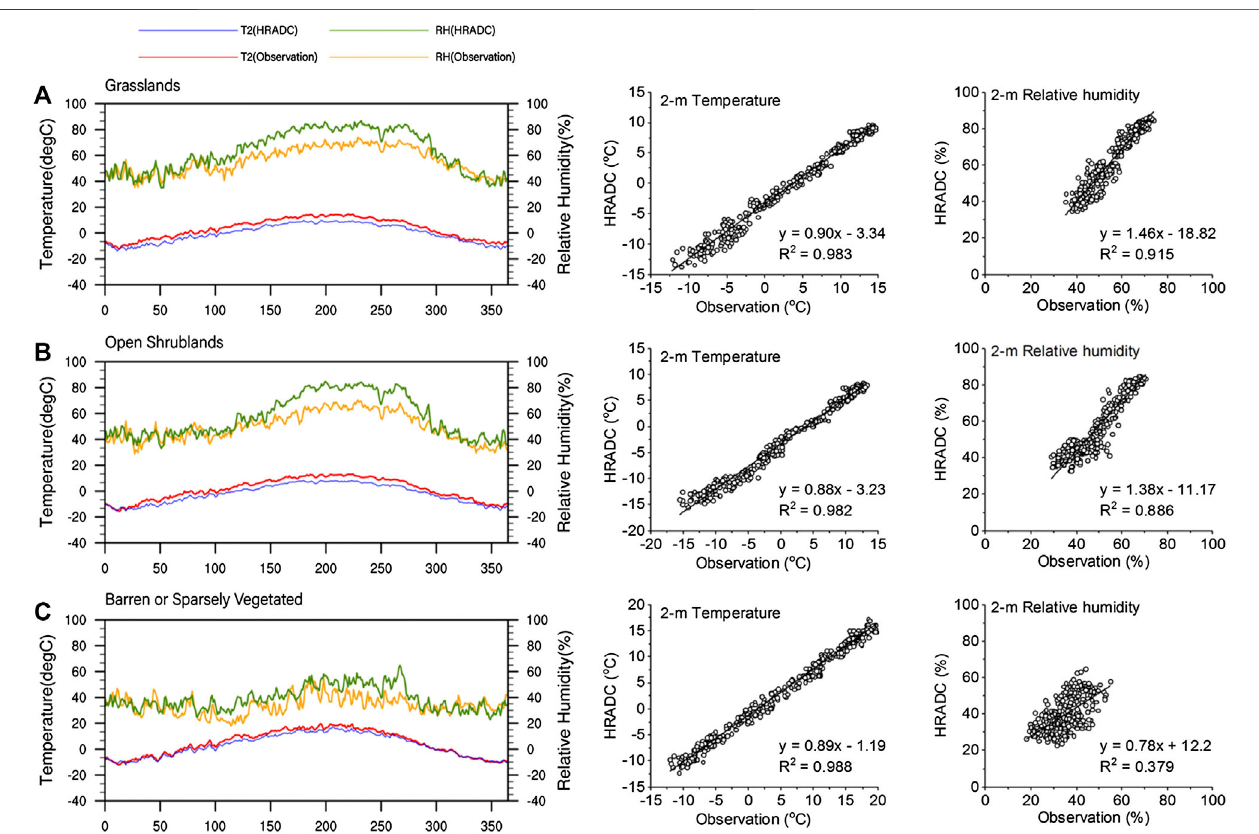
FIGURE 3 | Comparison of observations and High-Resolution Assimilation Dataset of the Water-Energy Cycle in China simulations, from three different underlying surfaces in Qinghai-Tibet Plateau, of the average daily value of 2-m temperature ( ° C) and relative humidity (%) during 2005 – 2012.